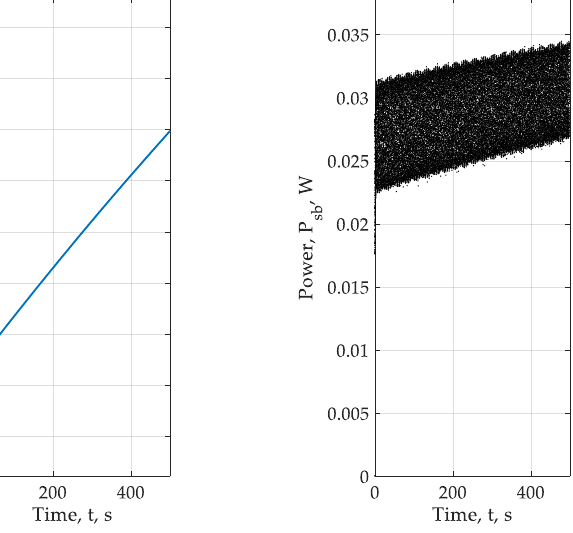
Figure 11. Experiment No.2 – Charles (1), 1981.